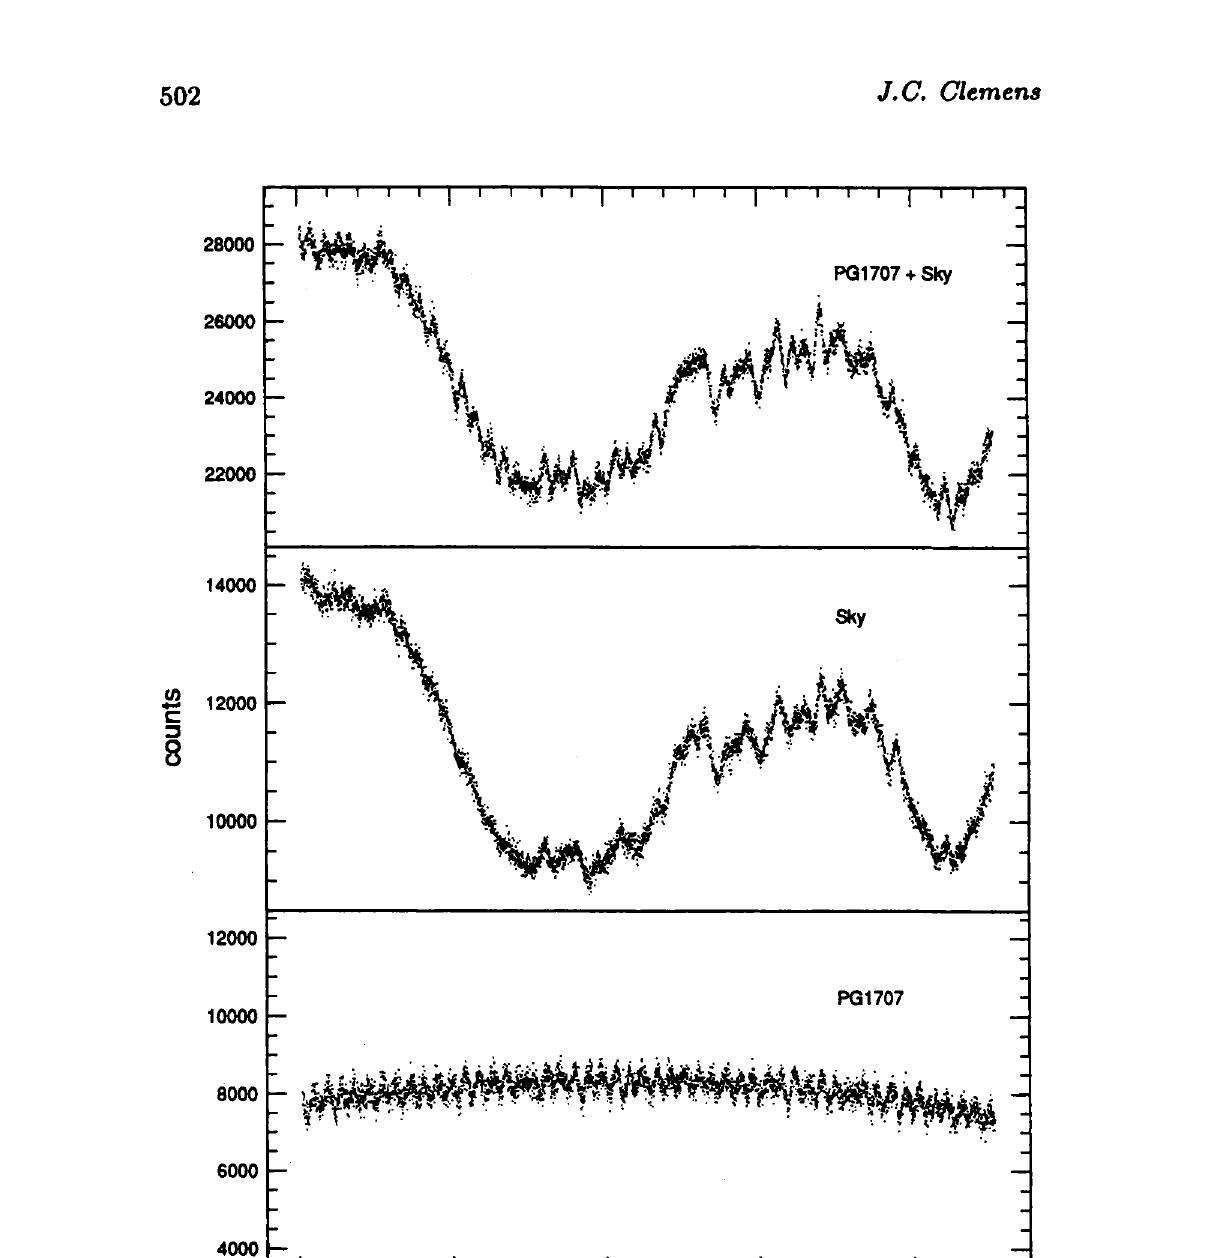
Fig. 1. PG 1707+427 before and after sky